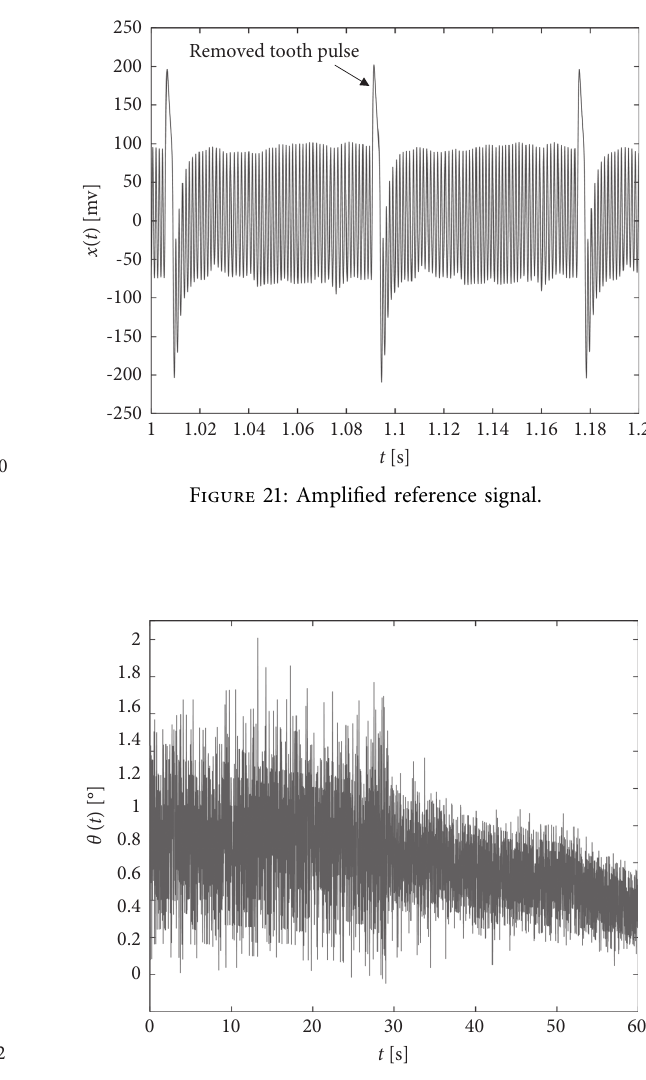
Figure 22: Torsional angle with static torsion effect of the propeller